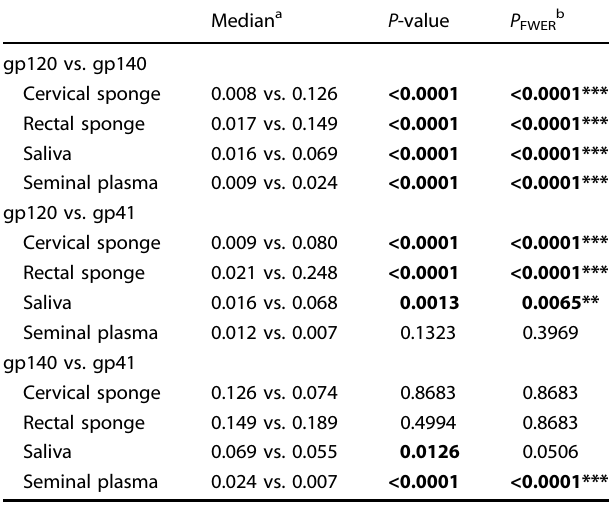
Table 3. Mucosal anti-gp41 and anti-gp140 IgG response magnitude is signi fi cantly increased vs. anti-gp120 IgG in cervical, rectal and oral